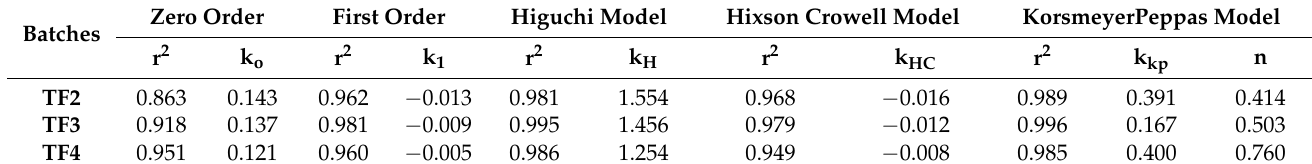
Figure 3. X-ray Diffraction pattern of drug, fibers, and transdermal films (TF4).